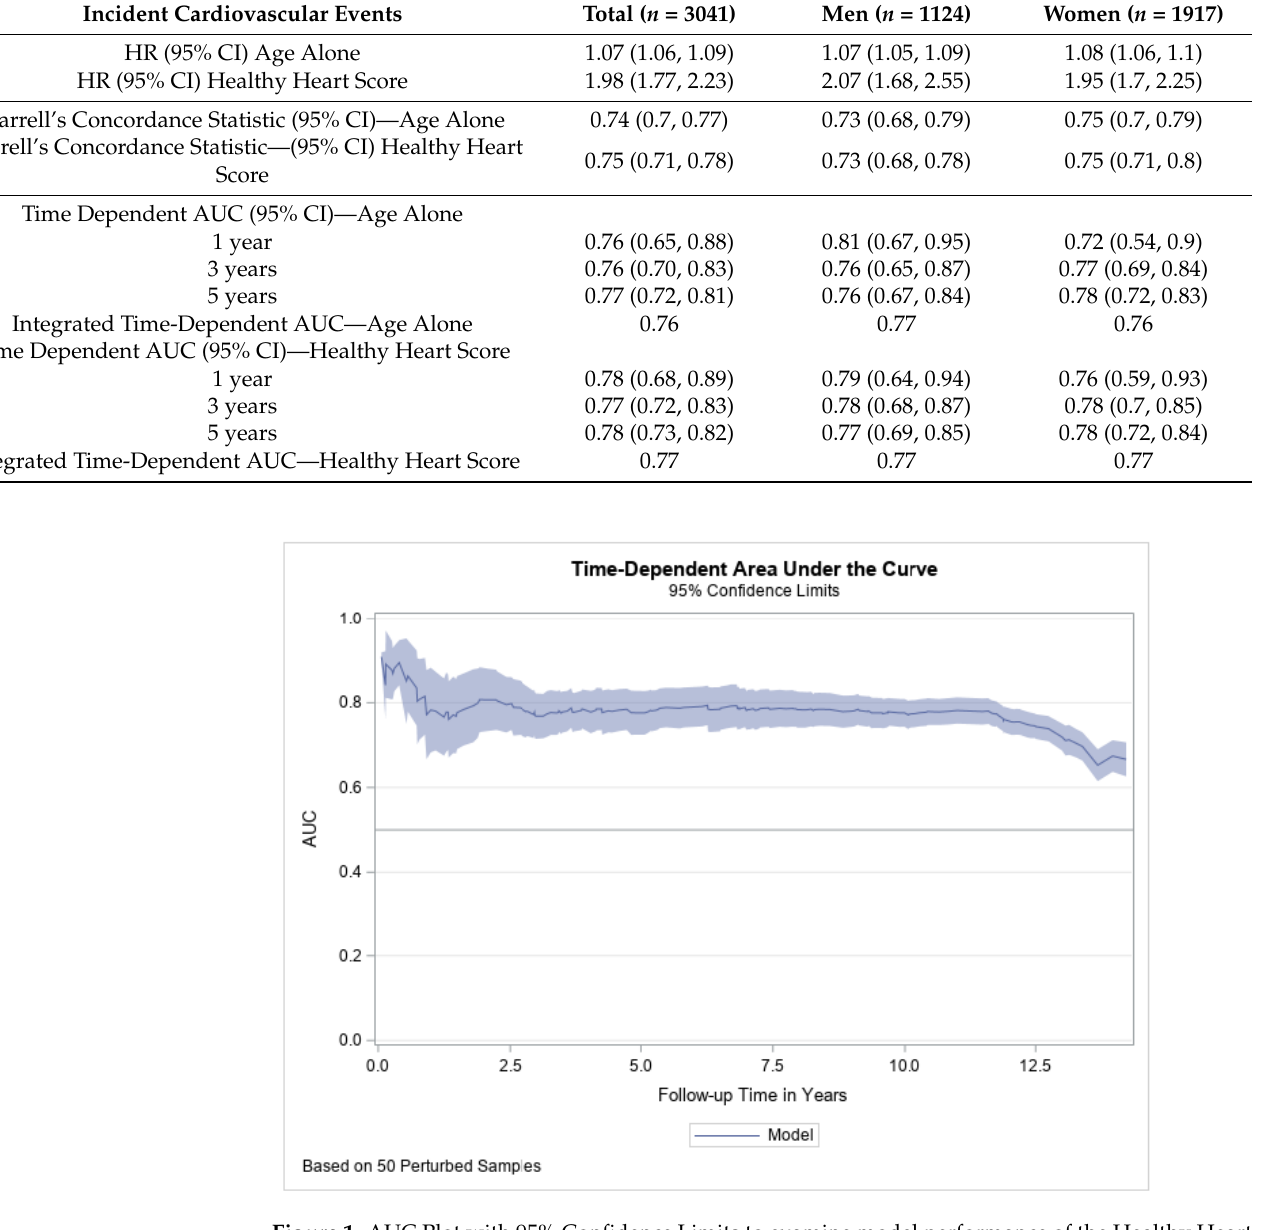
Figure 1. AUC Plot with 95% Confidence Limits to examine model performance of the Healthy Heart Score for Cardiovascular Events over 12 years.